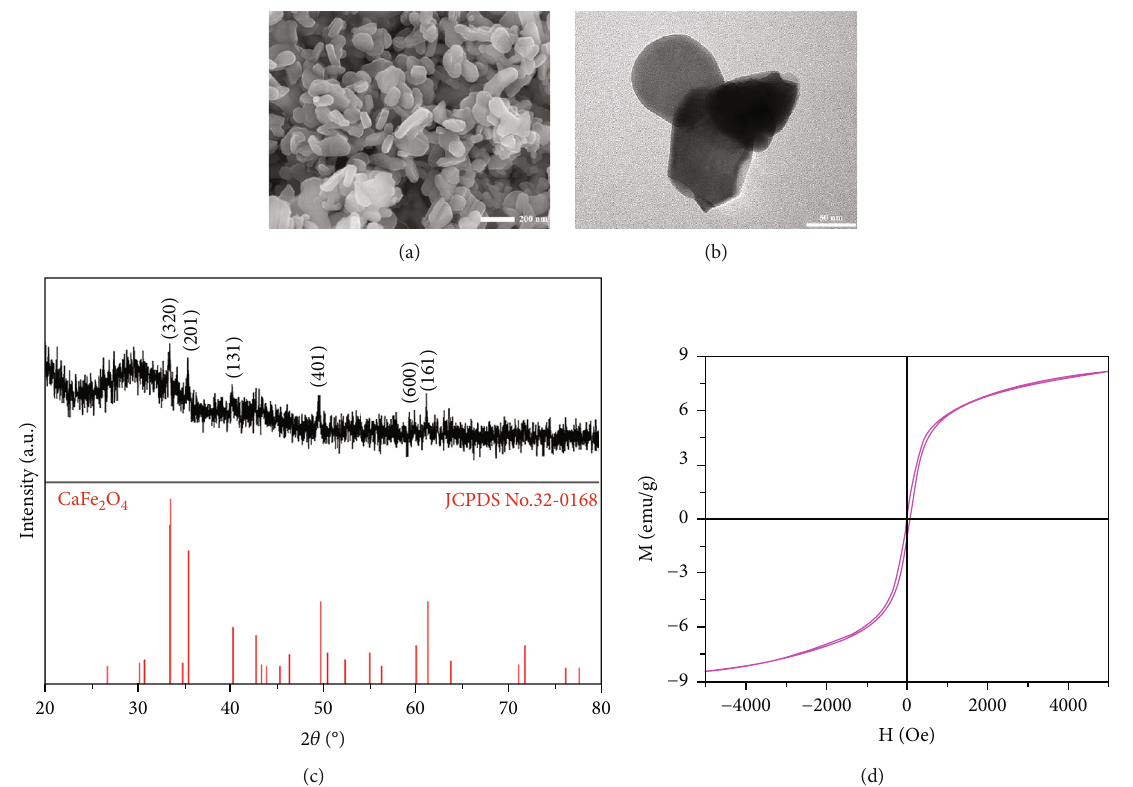
Figure 1: SEM morphology (a) and TEM image (b), XRD pattern (c), and VSM analysis (d) of CaFe